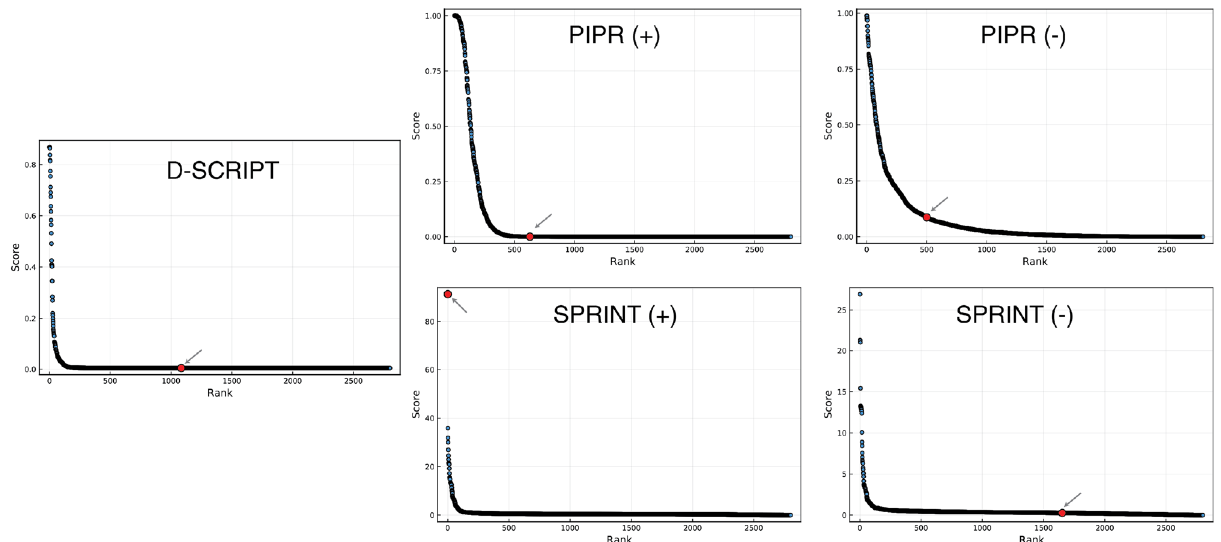
Figure 5. One-to-all curves for lixisenatide. The one-to-all curves generated using the predicted interaction scores of the three predictors are shown here. The true target protein is highlighted in red, while the black dots represent off-target proteins. One-to-all curves generated with predictors trained in the optimistic scenario are indicated with a (+).